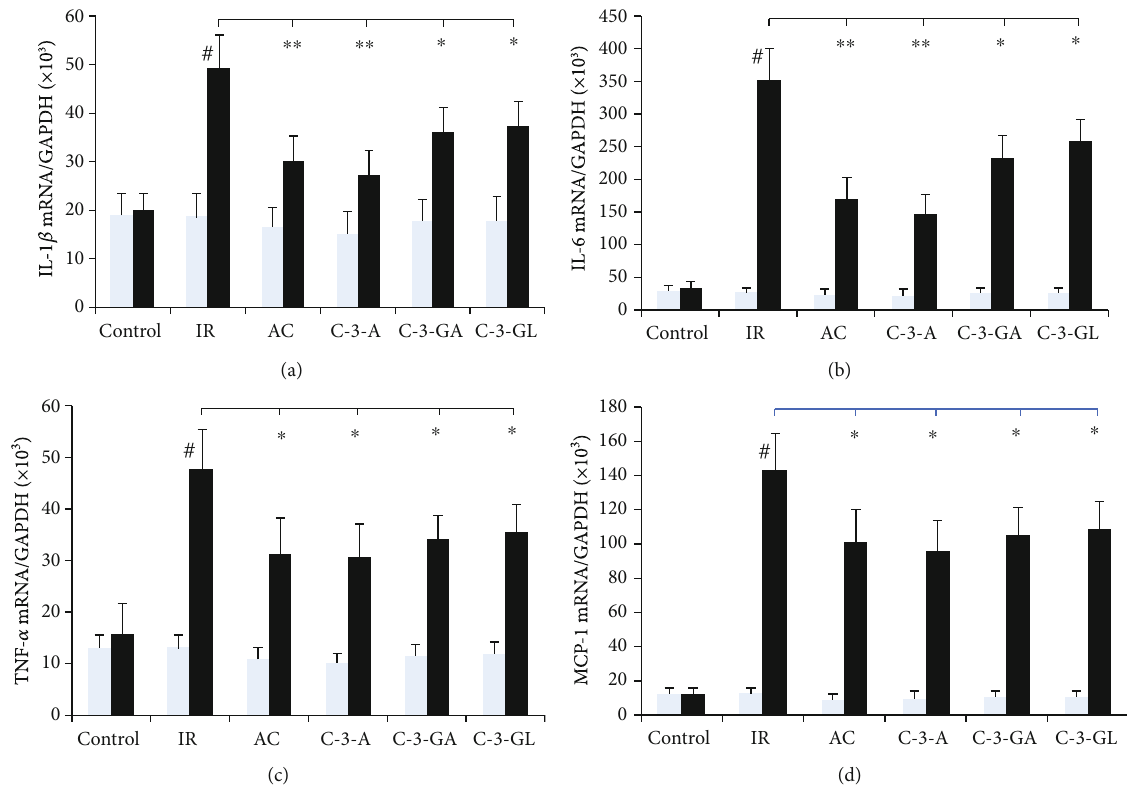
Figure 5: Proin fl ammatory cytokine ’ s mRNA expression in the renal IR injury and anthocyanin treatment. The data are the means ± SD . n = 13 per group. TNF- α : tumor necrosis factor- α ; IL-1 β : interleukin-1 beta; IL-6: interleukin-6; MCP-1: monocyte chemoattractant protein; IR: ischemic reperfusion; AC: anthocyanins; C-3-A: cyanidin-3-arabinoside; C-3-G: cyanidin-3-glucodise; C-3-GA: cyanidin-3- galactoside. # P < 0 : 01 vs. control within group; ∗ P < 0 : 05 and ∗∗ P < 0 : 01 vs. respective IR